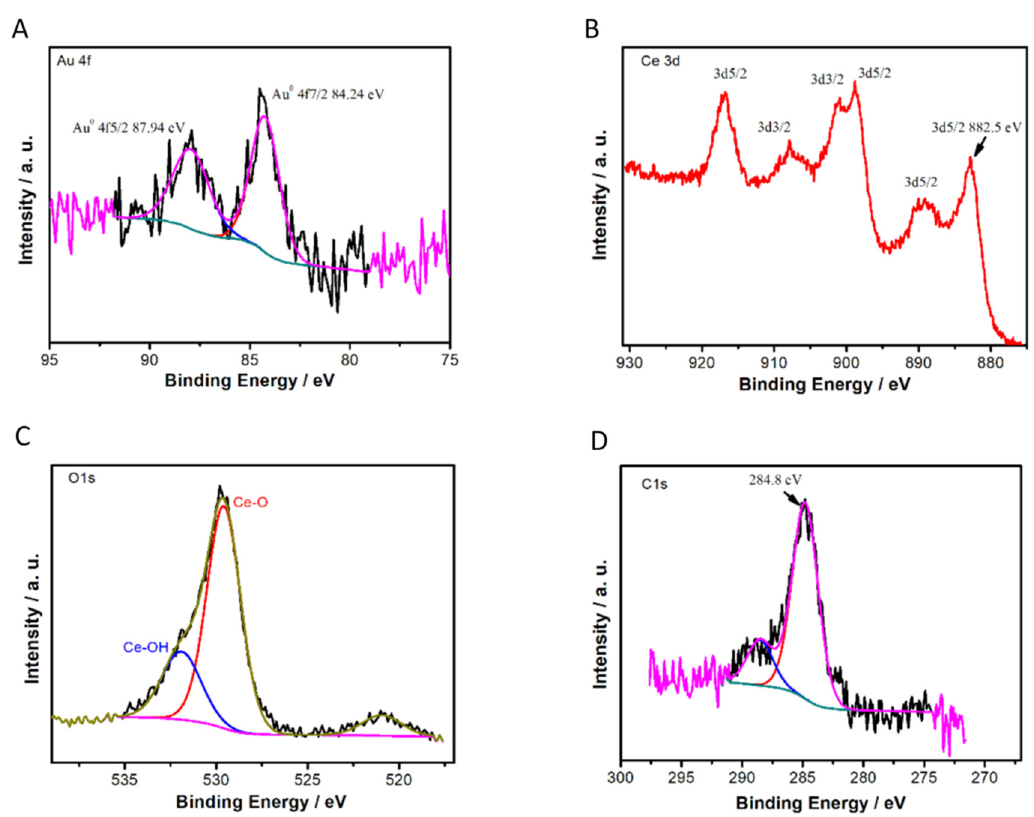
Figure 4. Experimental high resolution XPS peaks, best deconvolutions and assignments of Au 4f ( A ), Ce 3d ( B ), O1s ( C ) regions for a sample of 0.82% Au/CeO 2 and C1s ( D ) XPS spectra used as reference.